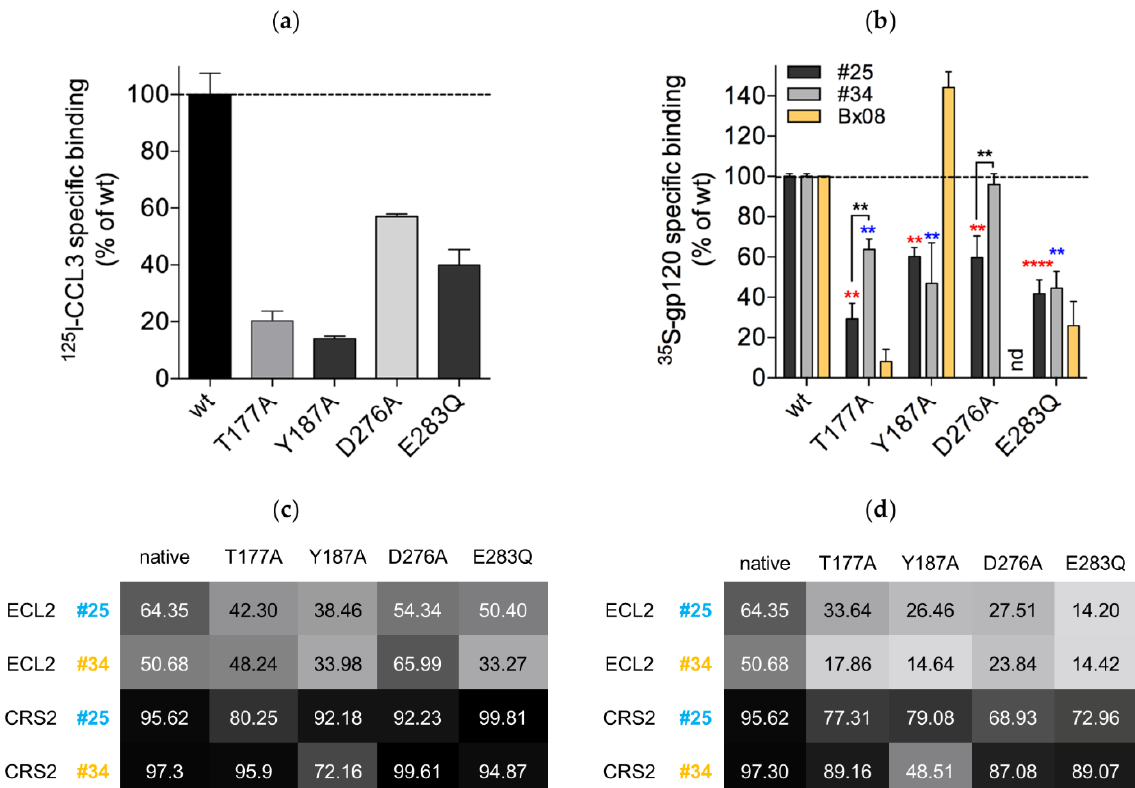
Figure 6. Mutations in CCR5 ′ s CRS2 differentially influence the binding of different gp120s: ( a ) specific binding of 125 I- CCL3 (0.2 nM) to membranes from HEK 293T cells expressing similar levels of wild-type (wt) CCR5 or the indicated CCR5 mutants. Specific binding was determined by subtracting from total binding the non-specific binding determined on wt-CCR5-expressing membranes in the presence of the CCR5 inverse agonist maraviroc at 10 µ M. Results are expressed relative to binding to the wild-type receptor. They represent means ± SEM of two independent experiments performed in duplicate; ( b ) specific binding of 35 S-labeled gp120 #25 , gp120 #34 or gp120 Bx08 (10 nM) in the presence of excess sCD4 (400 nM) to wt-CCR5 or CCR5 mutants. Results for gp120 Bx08 are from reference [58]. Results for gp120 #25 and gp120 #34 are from three independent experiments carried out in duplicate. Specific binding of the glycoproteins was determined as described above in panel ( a ). Results, which are expressed relative to wild-type CCR5, represent means ± SEM. nd: not determined. ** p < 0.01, **** p < 0.0001 using the Mann–Whitney U-test. Statistics in red and blue are relative to binding to wt-CCR5 for gp120 #25 and gp120 #34 , respectively; ( c ) percent of common positions of ECL2 and CRS2 during the simulations in wild-type CCR5 (native) or the indicated CCR5 mutants bound to gp120 #25 or gp120 #34 ; ( d ) percent of common positions of ECL2 and CRS2 during the simulations between native and mutated CCR5 bound to gp120 #25 or gp120 #34 ; ( c , d ). The proportion of common conformations is computed from the all-against-all comparison of one in ten snapshots issued from the simulation of the same complex ( c ) or the systematic pairwise comparison of one in ten snapshots issued during the simulation of the native and mutated complexes ( d ). Position is common to two snapshots if the deviation of the C α coordinates of the domain is low (RMSD < 2